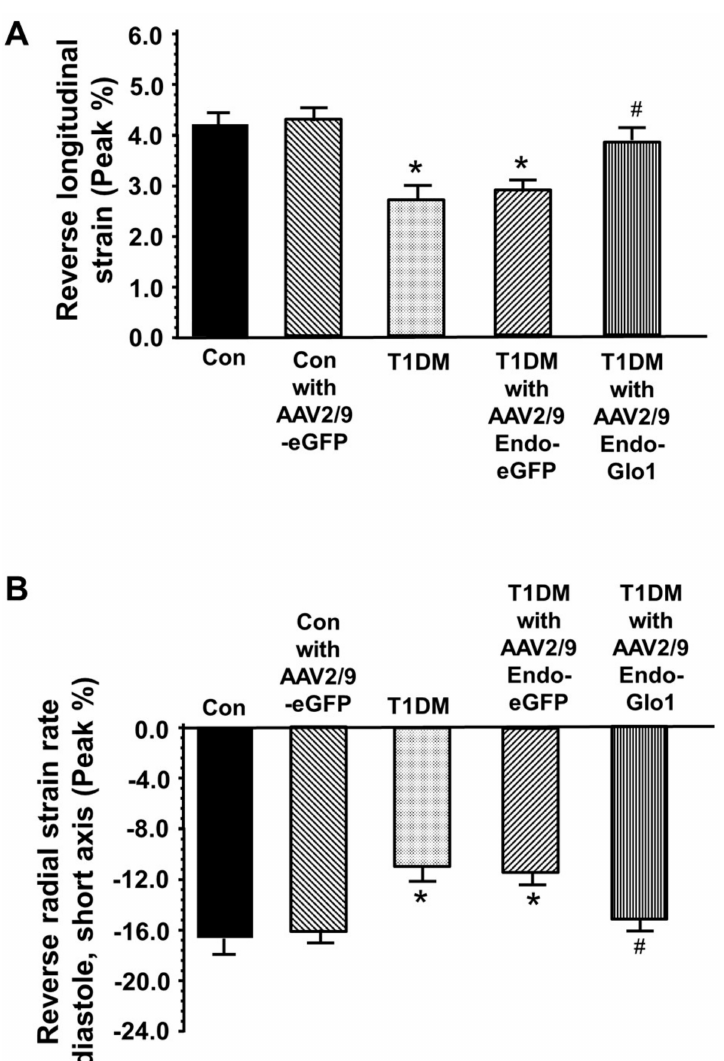
Figure 2. Bar charts showing reversed longitudinal ( A ) and radial strain rate ( B ) during early LV filling. For these measurements, the “reverse peak” algorithm in the Vevo Strain Software was utilized to analyze the B-mode images as described by Schnelle et al., 2018 [33]. Data shown are mean ± SEM. ( p < 0.05). The number of animals used per group is shown in the